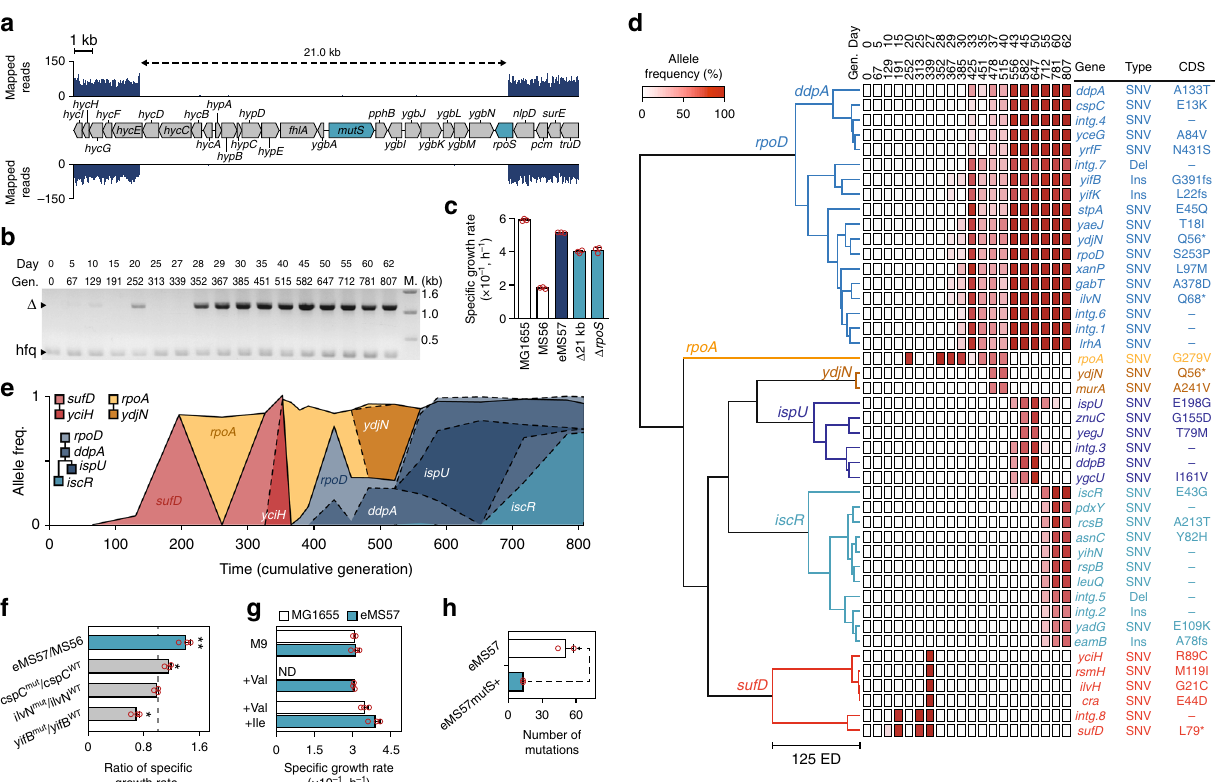
Fig. 2 Whole-genome resequencing of adaptive laboratory evolution (ALE) experiment. a Spontaneous large deletion in eMS57 spanning 21 kb including 21 genes. No sequencing read was mapped onto this region. b The occurrence of large deletions was tracked by PCR. Δ indicates PCR amplicon only ampli fi ed from the deletion. hfq was used as a positive control of PCR. Gen and M indicate cumulative generations and a DNA marker, respectively. c Growth rates of MS56 with rpoS deletion or a large deletion compared to MG1655 and eMS57. Error bars indicate the s.d. of three individual cultures shown in red circles. d Heatmap indicates frequencies of mutations in a given population. Shown are 31 mutations with allele frequency >0.5 at least once during ALE. Dendrogram shows clonal lineages determined by hierarchical clustering. Gen: cumulative generations, SNV: single-nucleotide variation, *: stop codon, fs: frame shift, ED: Euclidean distance. e Three lineages and their sub-lineages were inferred from hierarchical clustering. yciH sub-lineage emerged within the sufD lineage. ddpA , ispU , and iscR are sub-lineages of the rpoD lineage. ydjN is a sub-lineage of the rpoA lineage. Sub-lineages are presented as dotted